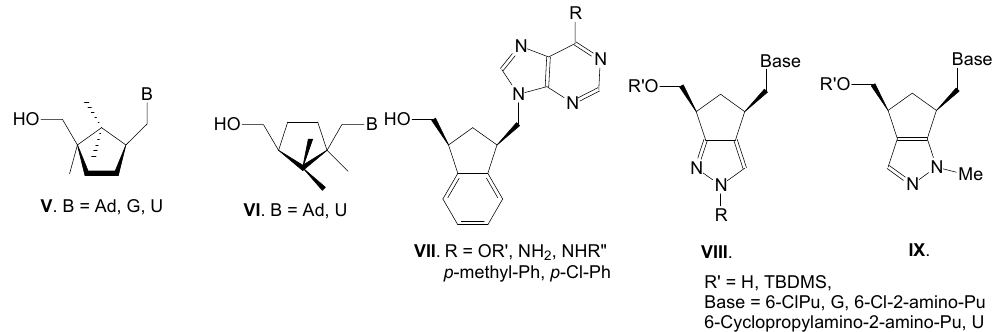
Figure 2. 1 ′ -Homocarbanucleosides with modified sugar with 2,2,3-trimethylcyclopentane, indane, cyclopenta[ c ]pyrazole, cyclopenta[ d ]pyrazole fragments.